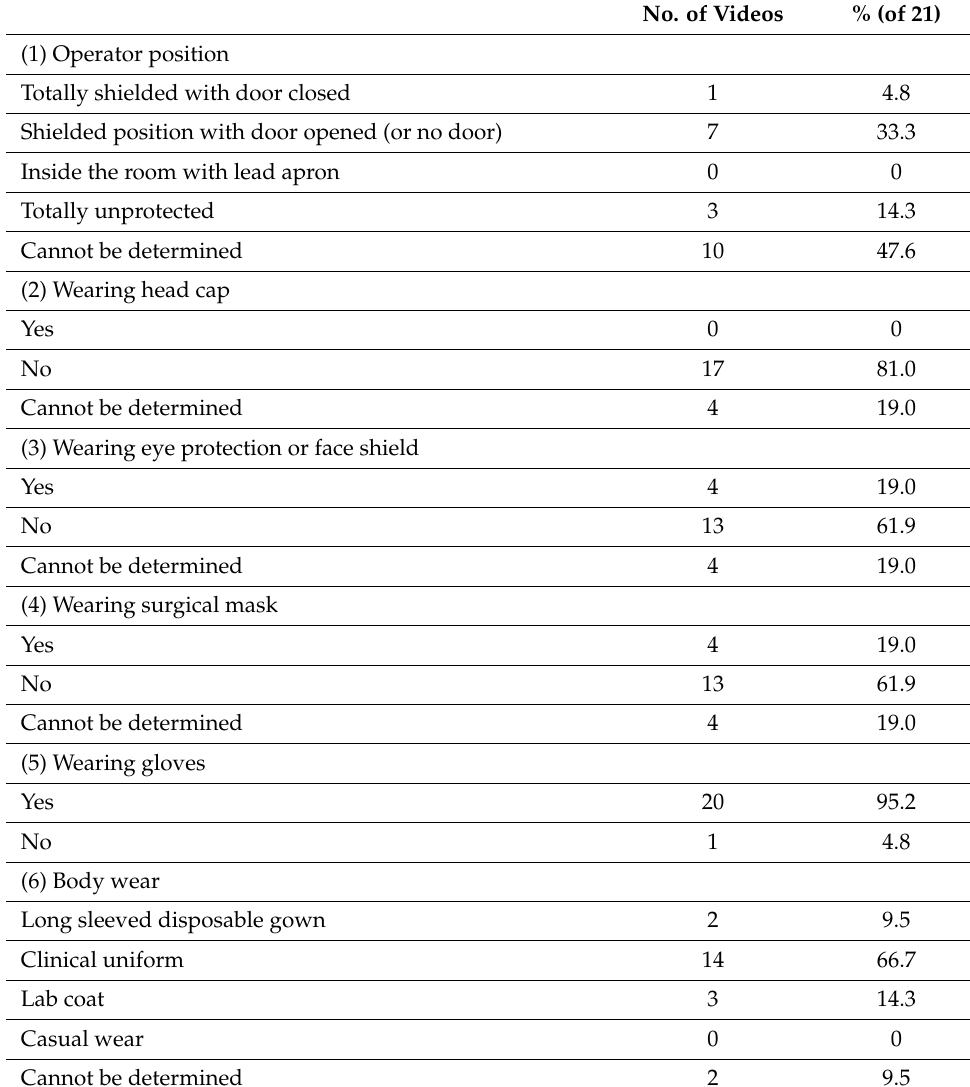
Table 3. The frequency counts of operator safety